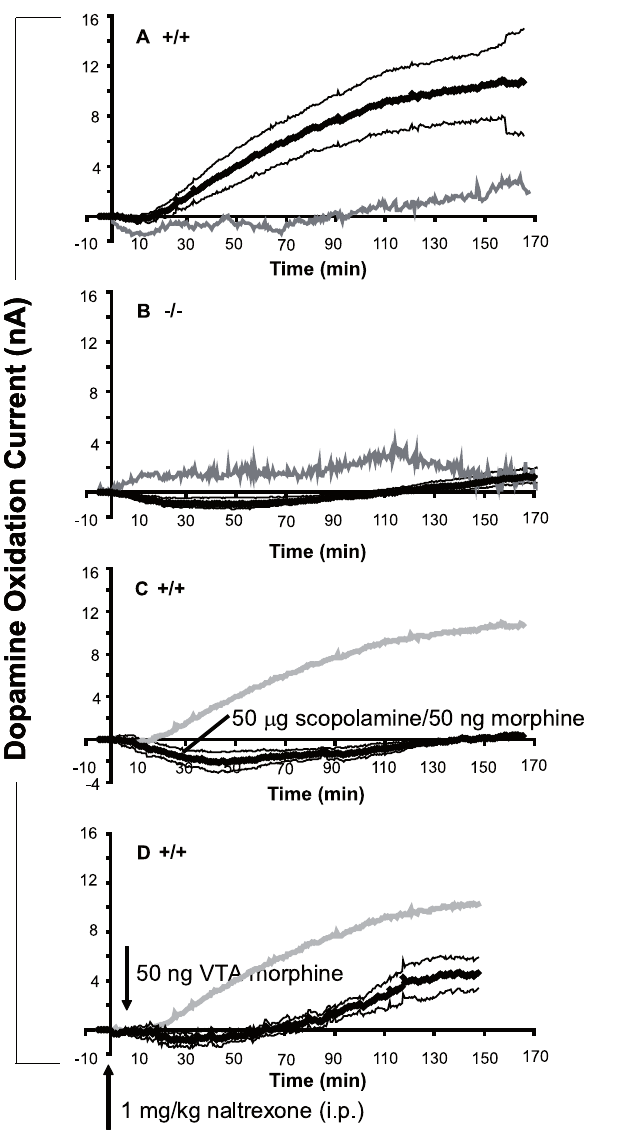
Figure 2. Changes in accumbal dopamine efflux produced by 50 ng intra-VTA morphine or saline in wildtype ( + / + ) or M 5 knockout ( 2 / 2 ) mice. In all cases, thick lines represent mean dopamine oxidation current across mice, and thin lines represent 6 SEM. (A) Mean change in accumbal dopamine efflux in wildtype mice following 50 ng intra-VTA morphine (black line, n=4) or 0.3 m l intra- VTA saline (gray line, n=4). (B) Mean change in accumbal dopamine efflux in M 5 knockout mice following 50 ng intra-VTA morphine (black line, n=4) or 0.3 m l intra-VTA saline (gray line, n=4). (C) Effects of pre- treatment with 50 m g intra-VTA scopolamine on accumbal dopamine efflux induced by 50 ng intra-VTA morphine in wildtype mice (black line, n=6). For comparison, data from (A) showing mean changes in accumbal dopamine efflux induced by 50 ng intra-VTA morphine without any pre-treatment in wildtype mice are reproduced (gray line, n=4). (D) Effects of pre-treatment with naltrexone (1 mg/kg, i.p.) 5 min prior to 50 ng intra-VTA morphine in wildtype mice (black line, n=4). For comparison, data from (A) showing mean changes in accumbal dopamine efflux induced by 50 ng intra-VTA morphine without any pre-treatment in wildtype mice are reproduced (gray line, n=4).